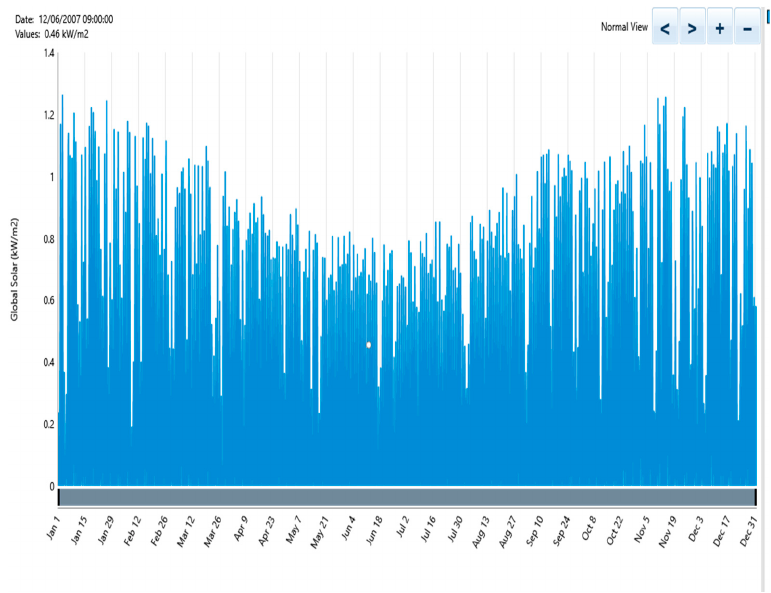
Figure 1. Yearly solar irradiance pattern for Gwakwani area.